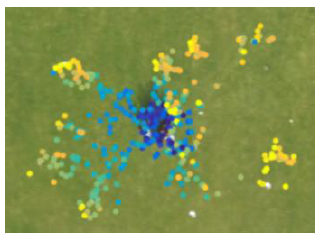
Figure 15. Result of the “Panic” scenario visualised as points with a gradient colour